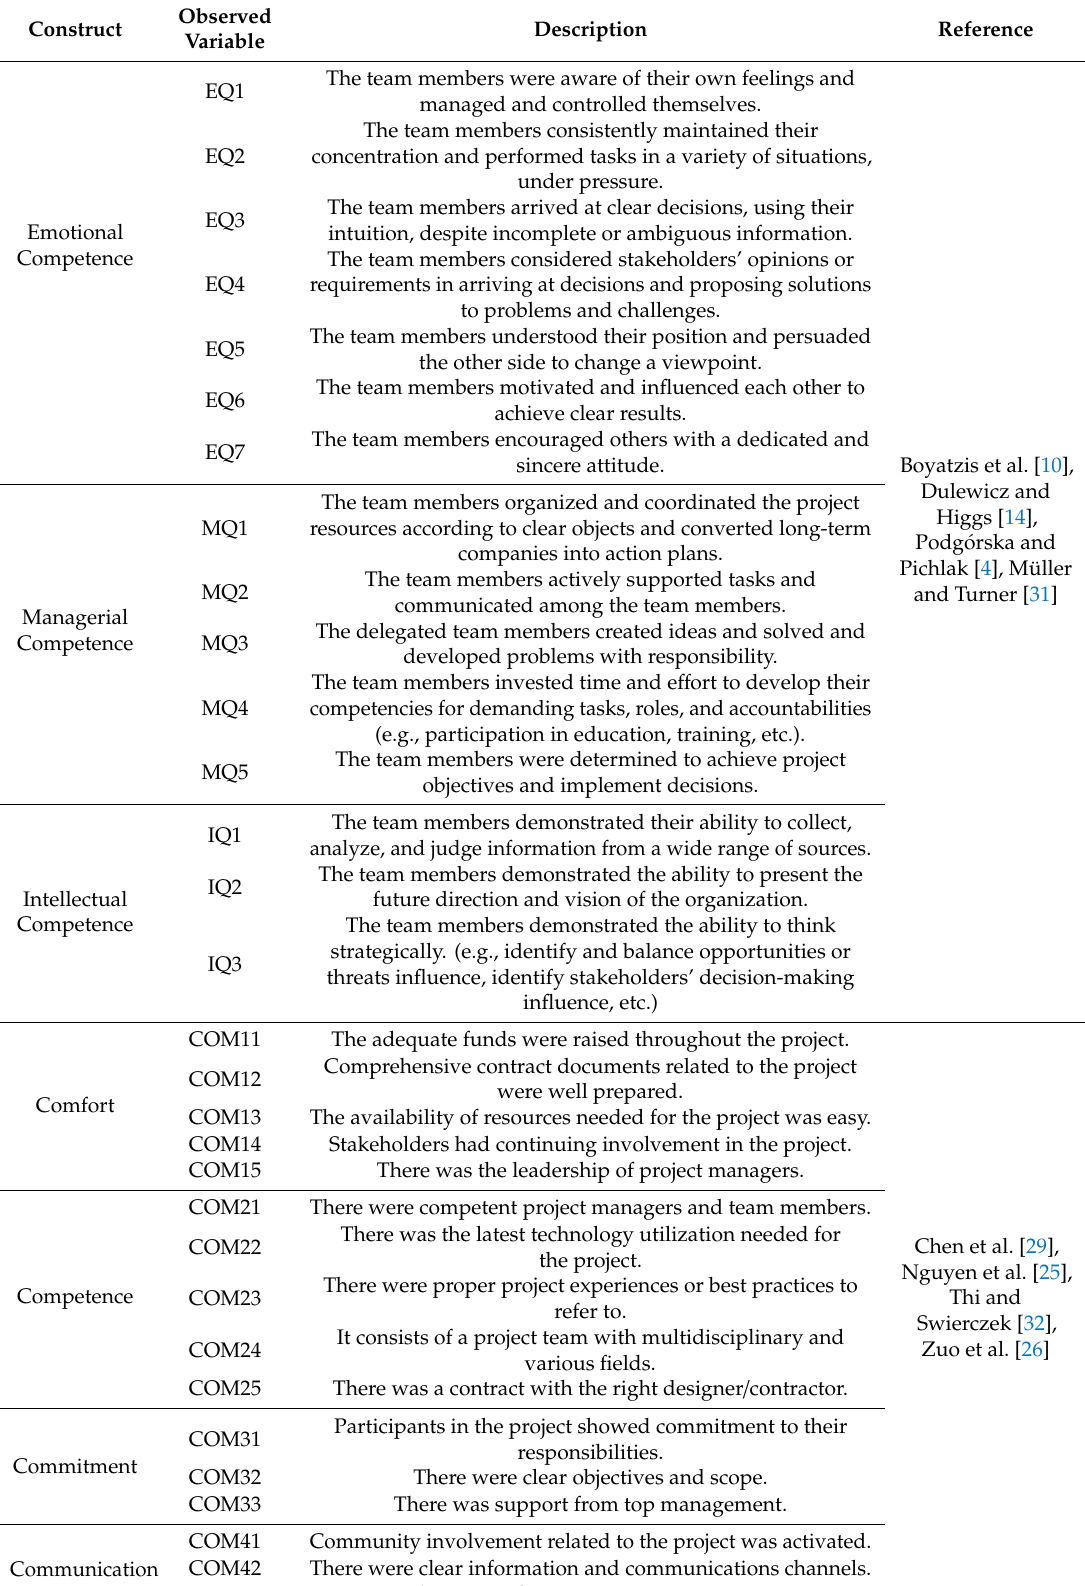
Table 1. Measurement variable and questionnaire